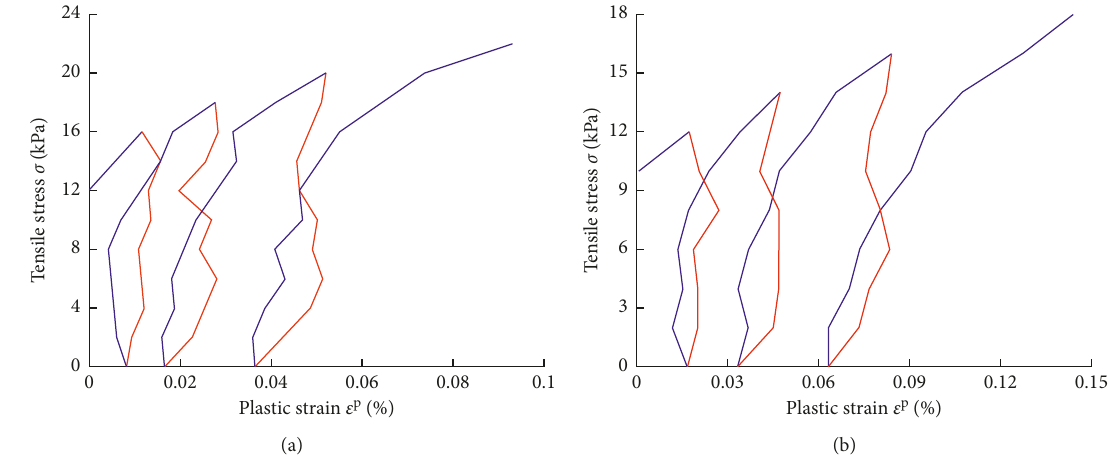
Figure 12: Stress-plastic strain curves of the cyclic tensile tests for load pattern II: (a) w � 16%; (b) w � 18%.